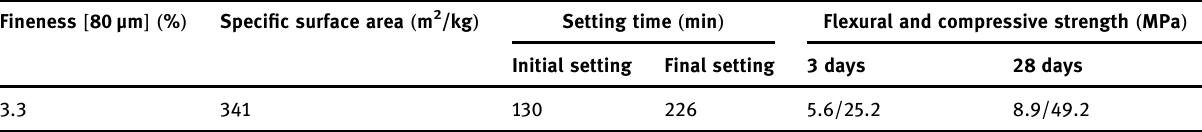
Table 1: Physical performance indexes of cement Fineness [ 80 μ m ] ( % )